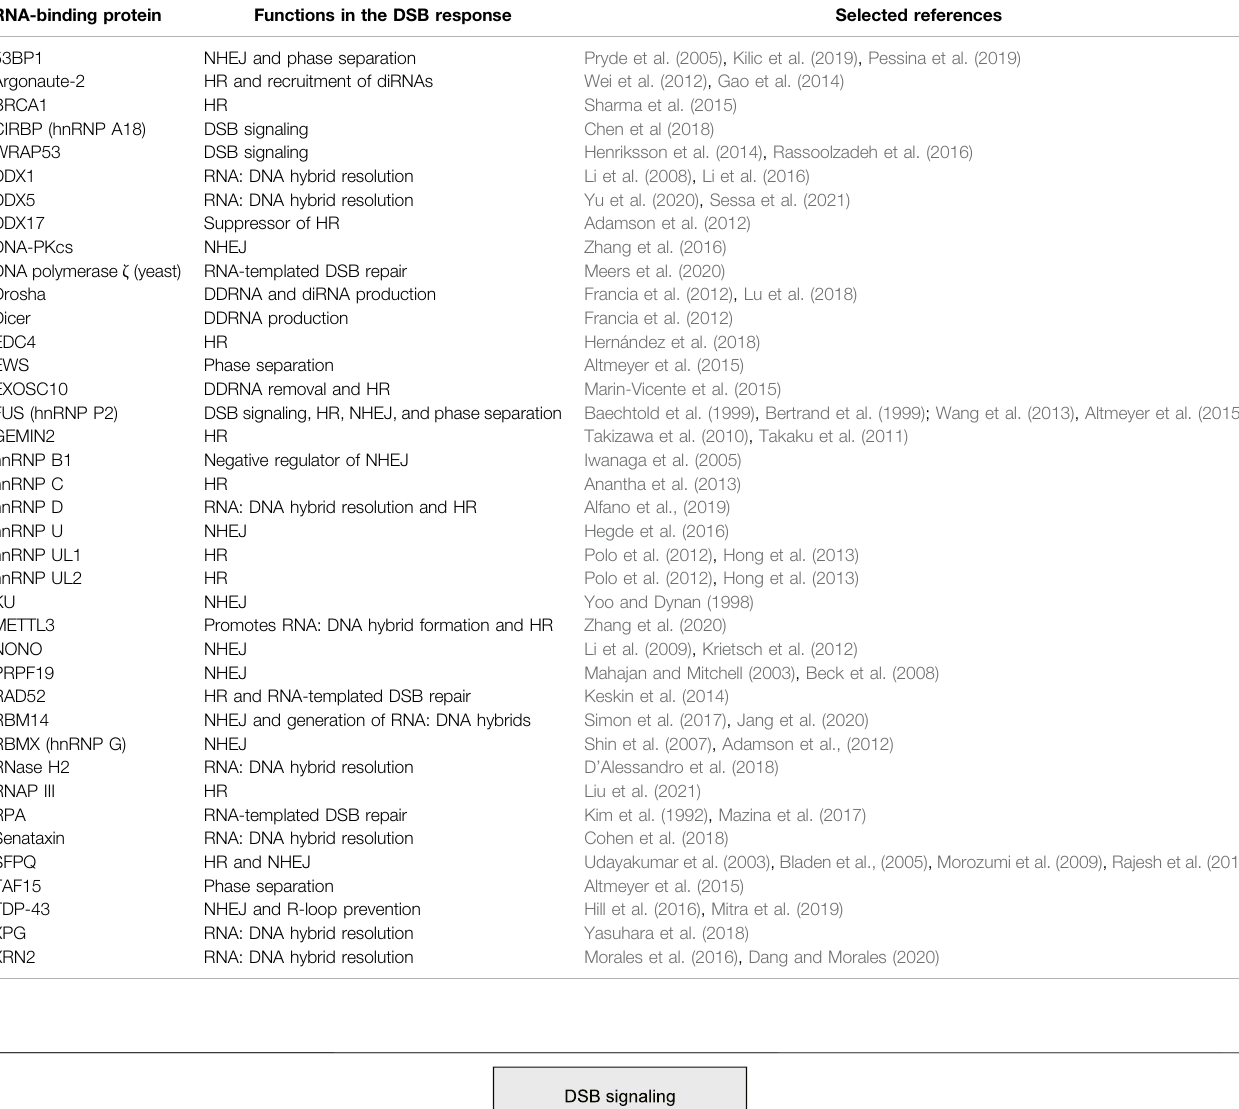
TABLE 1 | List of human RNA-binding proteins that participate in the chromatin-based DSB response. RNA-binding protein